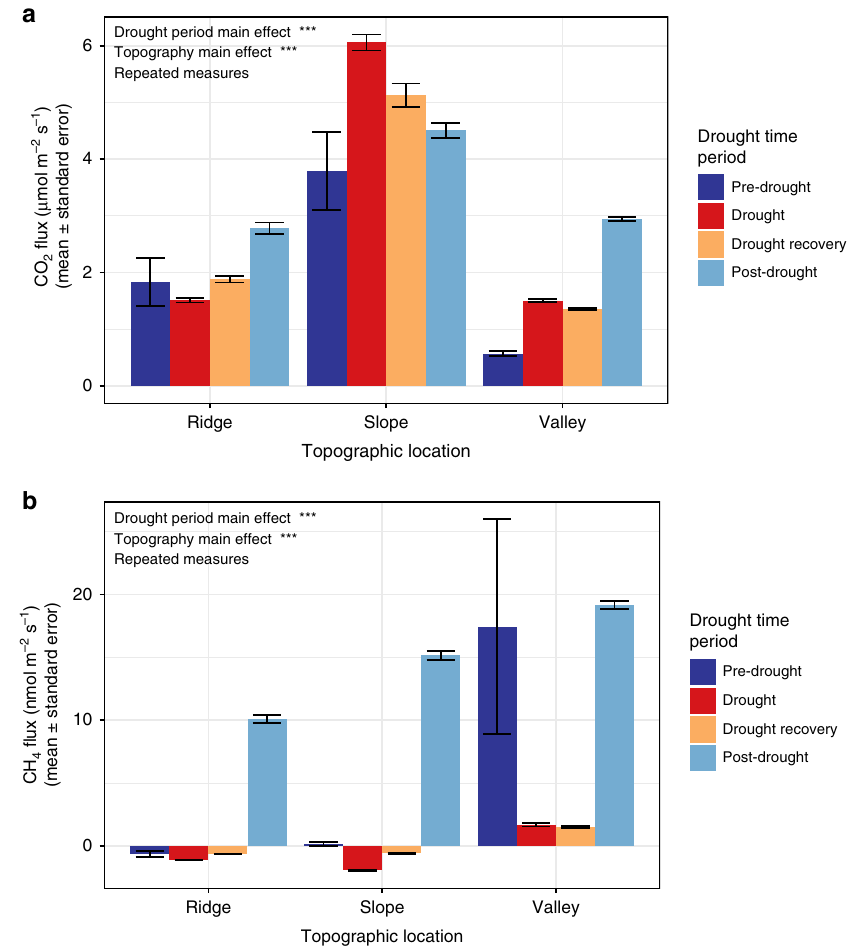
Fig. 3 Soil greenhouse gas emissions across topographic zones. Bars are the mean fl ux of CO 2 ( a ) and CH 4 ( b ) for each drought period; error bars represent ±1 s.e.m. Statistical results are reported from a two-way, repeated measures ANOVA in which drought period and topographic location were predictors of GHG fl uxes; effects are marked as *** when p -value <0.001, ** when p -value <0.01, * when p -value <0.05, and as NS when p -value ≥